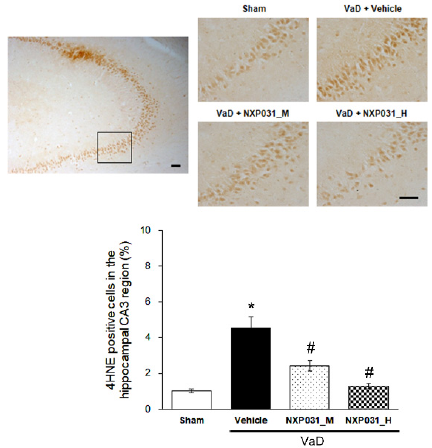
Figure 5. Effect of NXP031 on CCH-induced 4HNE production in the hippocampal CA3 region. Representative photographs of immunostaining of 4HNE expression in the hippocampal CA3 regions after CCH. The data are presented as the mean ± S.E.M. * p < 0.05, compared with the sham group. # p < 0.05, compared with the VaD group. Scale bar: 100 μ m.